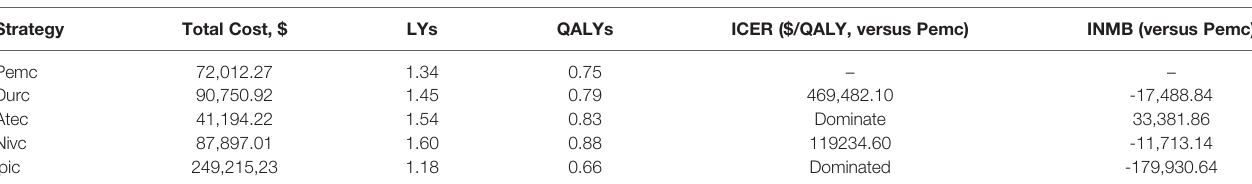
TABLE 3 | Base-case